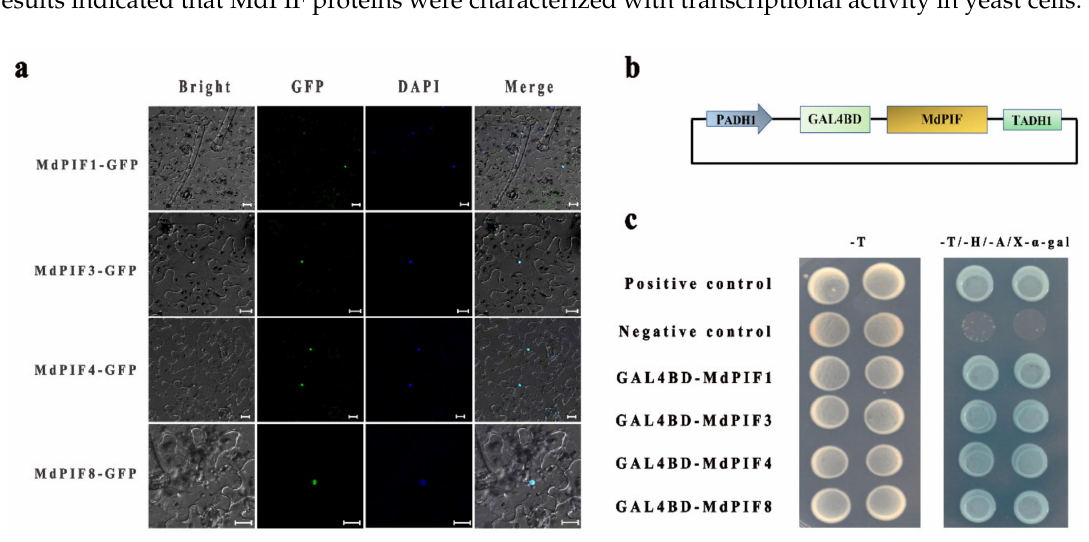
Figure 5. Subcellular localization and transactivation assay of MdPIF proteins. ( a ) Subcellular localization of MdPIF proteins. Scale bar = 20 µ m. ( b ) Schematic diagram of the MdPIF-pGBKT7 structure. ( c ) The construct of pGBKT7-MdPIF was transformed into yeast strain AH109 and examined on SD / -Trp and SD / -Trp / -His / -Ade / X- α -gal